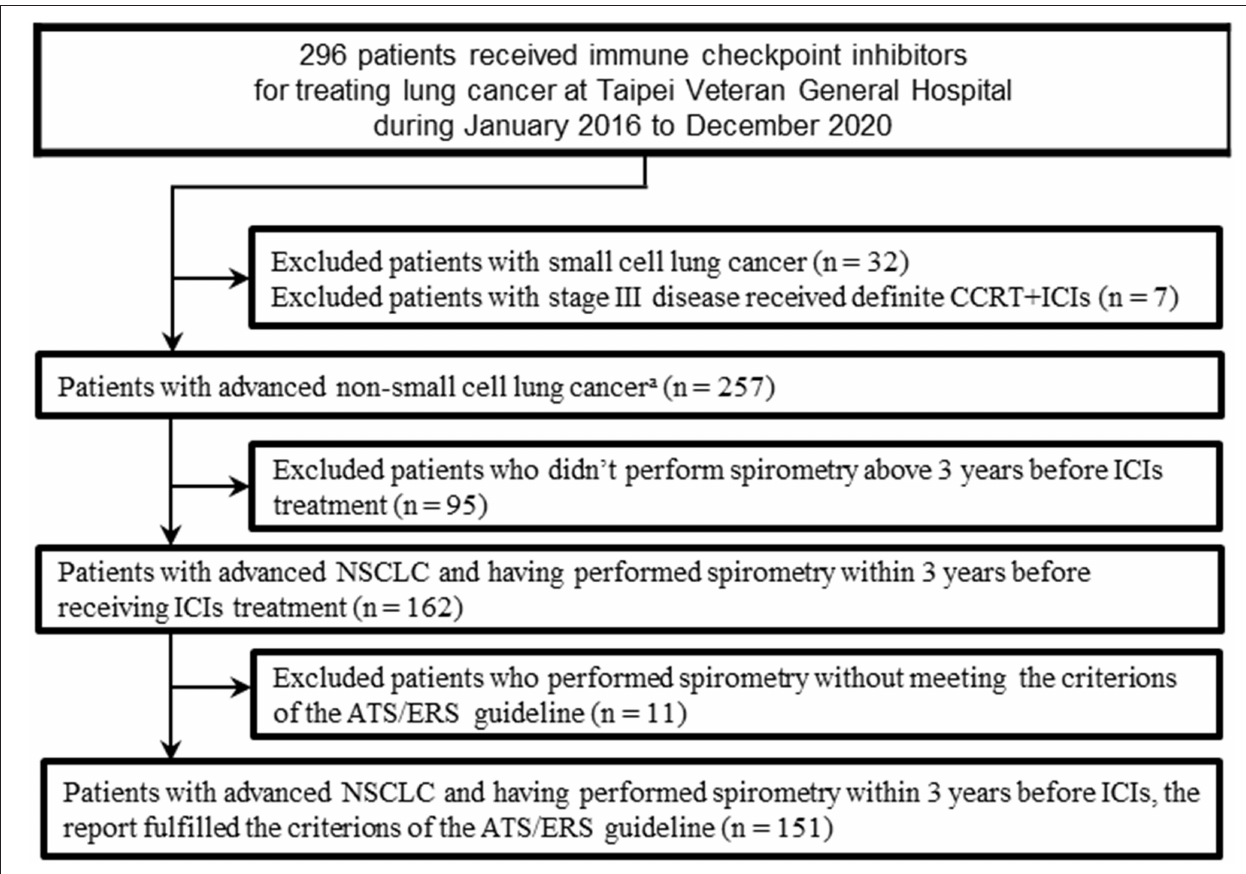
FIGURE 1 | Flow chart of the study population. ATS, American Thoracic Society; CCRT, concurrent chemoradiotherapy; ERS, European Respiratory Society; ICI, immune checkpoint inhibitors; NSCLC, non-small cell lung cancer. a Included adenocarcinomas, squamous cell carcinomas, adenosquamous carcinomas, large cell carcinomas, sarcomatoid carcinomas, large cell neuroendocrine carcinomas, and non–small-cell carcinomas not otherwise specified. in the multivariate analysis. All tests were two-sided, and p <